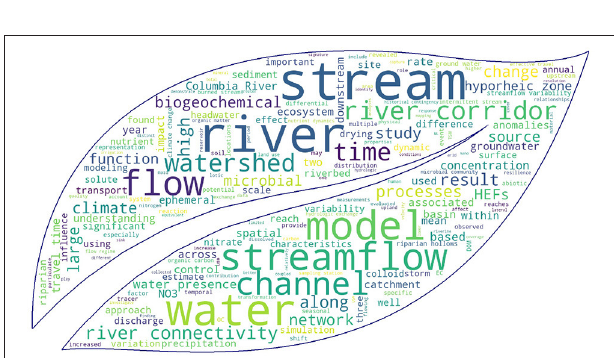
FIGURE 2 | Linking hydrological and biogeochemical processes in riparian corridors include a wide spectrum of topics, such as hydrologic exchange and river connectivity, geochemical exports, and microbial dynamics addressing critical gaps in our understanding of changes in river corridors over different spatial and temporal